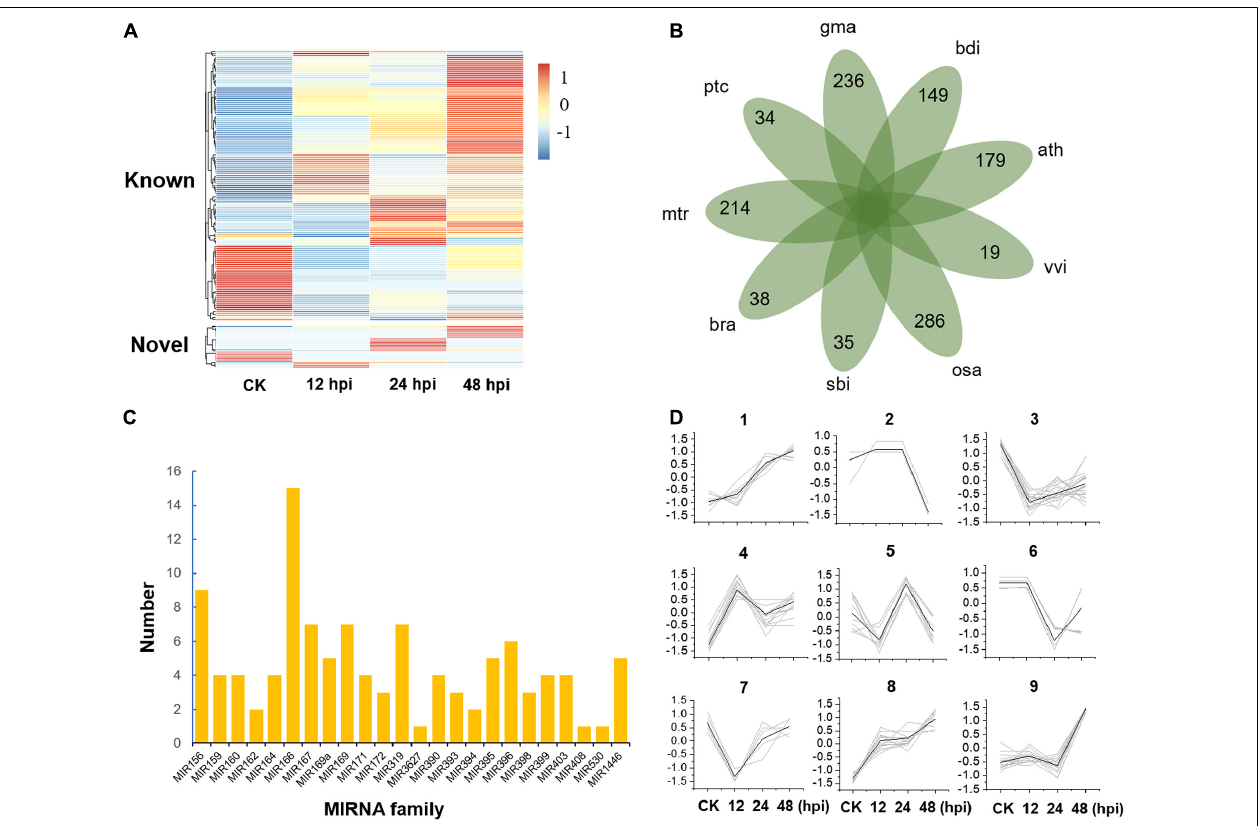
FIGURE 1 | Expression and classification of microRNAs (miRNAs). (A) Expression of known and novel miRNAs. hpi, hours post-inoculation. (B) The species-specific miRNA families of nine plant species. ptc, Populus trichocarpa ; mtr, Medicago truncatula ; bra, Brassica rapa ; sbi, Sorghum bicolor ; osa, Oryza sativa ; vvi, Vitis vinifera ; ath, Arabidopsis thaliana ; bdi, Brachypodium distachyon ; gma, Glycine max . (C) The distribution of 110 conserved miRNA members in 23 miRNA families. (D) Nine clusters were obtained by K- means clustering with Euclidean distance as the distance